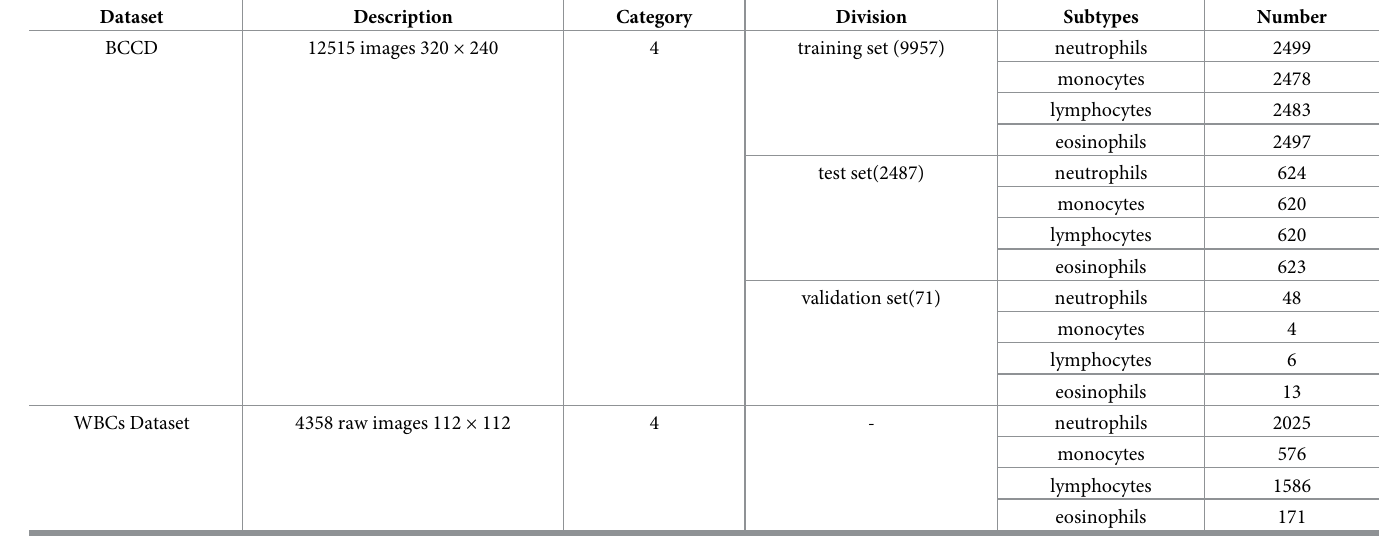
Table 1. Descriptions of BCCD and WBCs dataset. Dataset